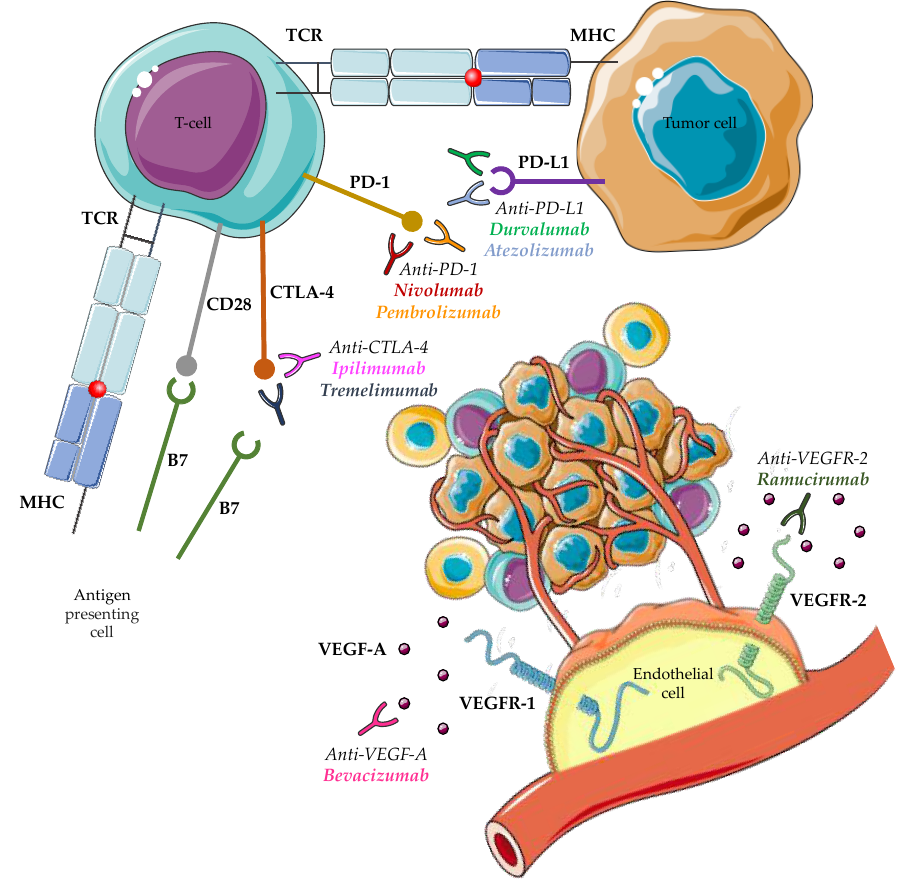
Figure 2. Mechanism of action of FDA-approved monoclonal antibodies for unresectable hepatocellular carcinoma. Table 1. The use of FDA-approved monoclonal antibodies in patients with unresectable hepatocellular carcinoma.